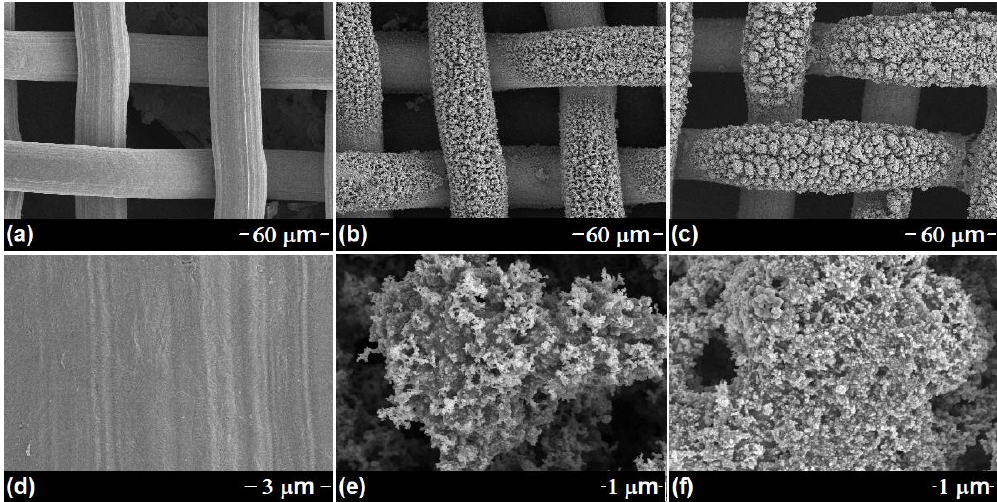
Figure 2. FESEM images of SSM ( a , d ), Fe 2 O 3 -NCs@SSM ( b , e ), OTS@Fe 2 O 3 -NCs@SSM ( c , f ).